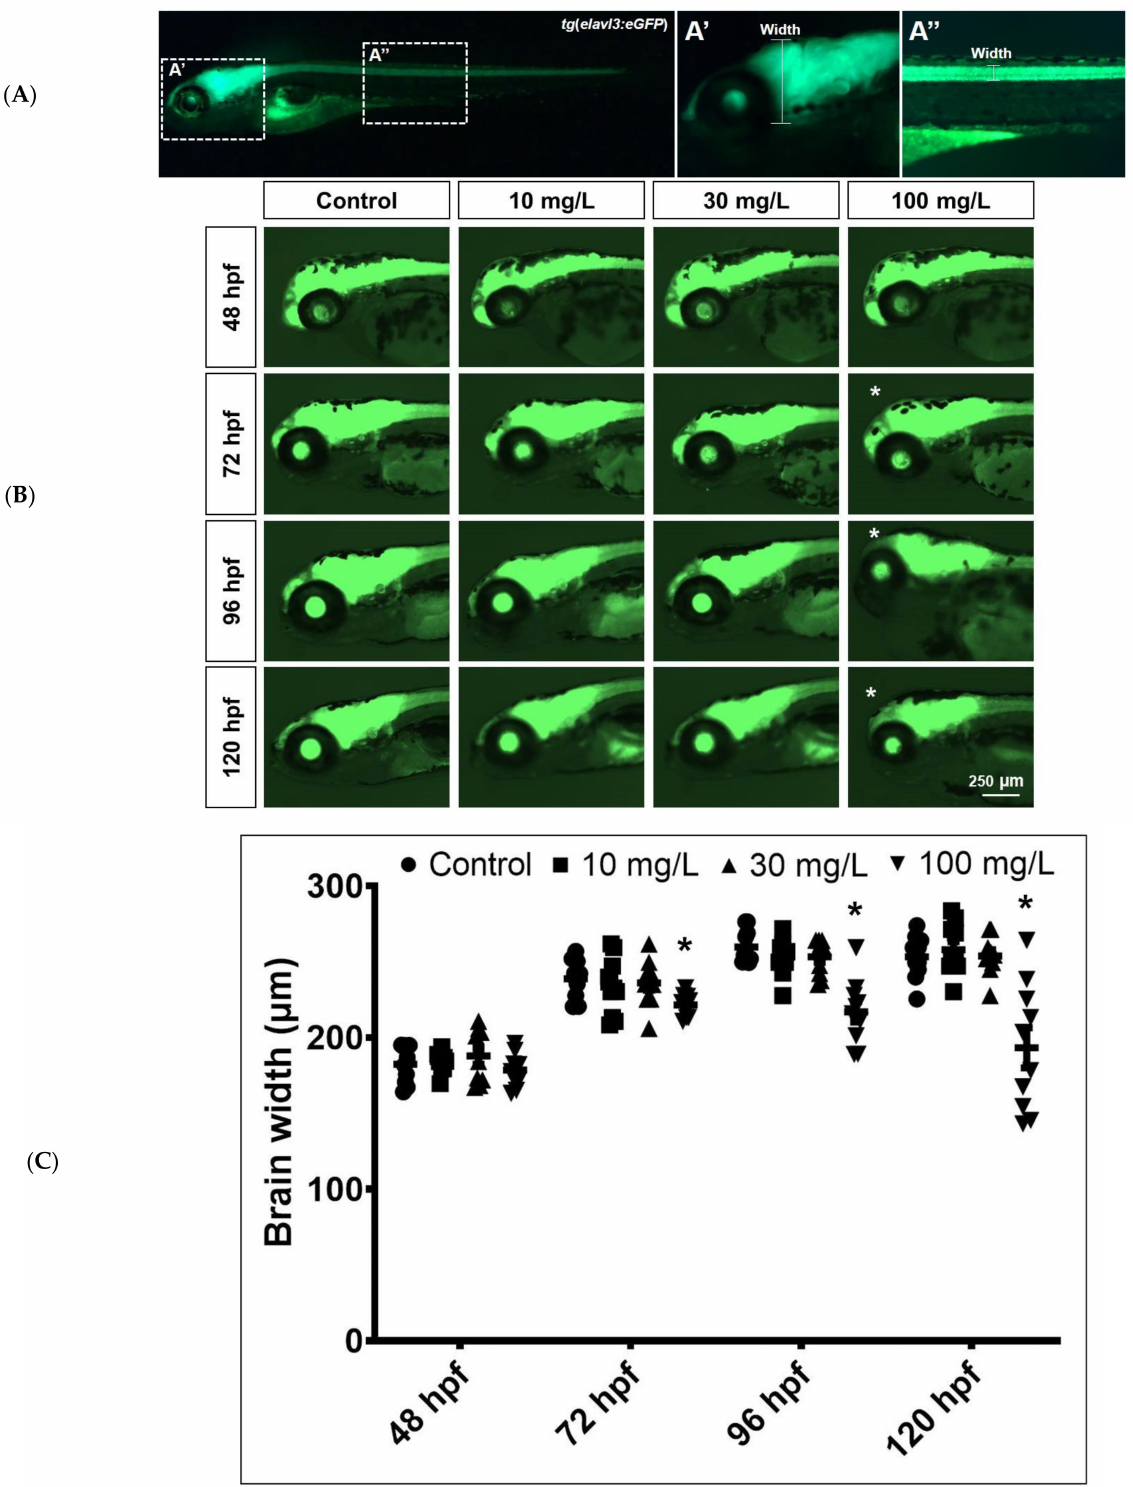
Figure 3. Acrylamide-induced neurotoxicity in transgenic tg ( elavl3:eGFP ) zebrafish. ( A –A”). Pan-neuronal cells were used to analyze neurotoxicity. Brain width (A’) and spinal cord neuron width (A”) were measured. ( B ). Brain neurotoxicity. From 72 hpf onwards, zebrafish larvae treated with 100 mg/L acrylamide exhibited shorter brain width than controls. White asterisks denote severely short brain width. ( C ). Brain width. Brain width was shorter at the 72–120 hpf measurement time points in fish exposed to 100 mg/L acrylamide ( n = 10). * p < 0.01. Error bars represent the standard error of the